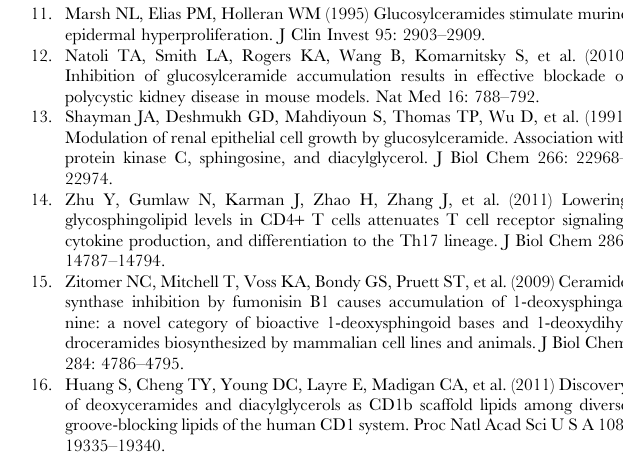
Figure S2 The increased sphingolipid abundances ob- served in aged CD4 + T cell IS fractions are largely independent of fatty acyl chain length. Individual subspecies amounts present in bead-enriched (IS) fractions prepared from equivalent numbers (20 6 10 6 ) of purified young and old murine CD4 + T cells. White bars indicate results for young CD4 + T cells. Gray bars show results for old CD4 + T cells. The data represent mean picomoles 6 SEM of each sphingolipid subspecies detected in the two independent experiments shown in Figure